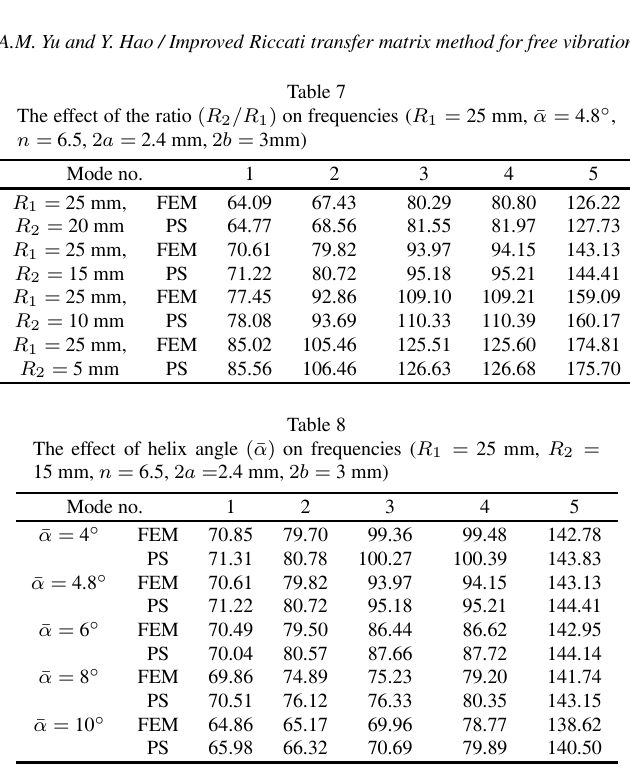
Table 9 The effect ofnumber of active turns ( n ) onfrequencies ( R 1 = 25 mm, R 2